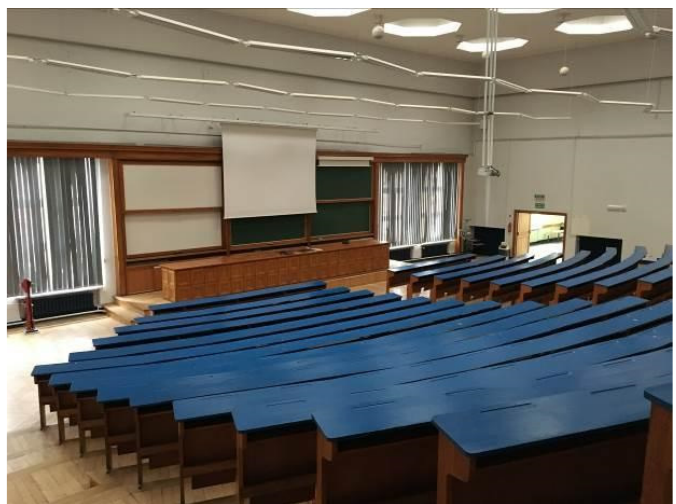
Figure 3. The lecture room where the survey was conducted.